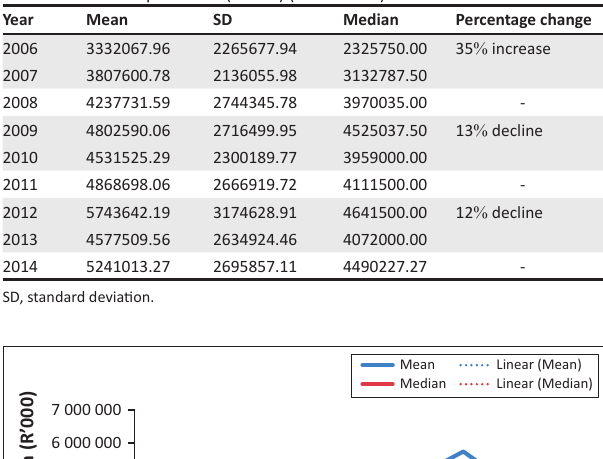
TABLE 3: Fixed pay (R‘ 000)